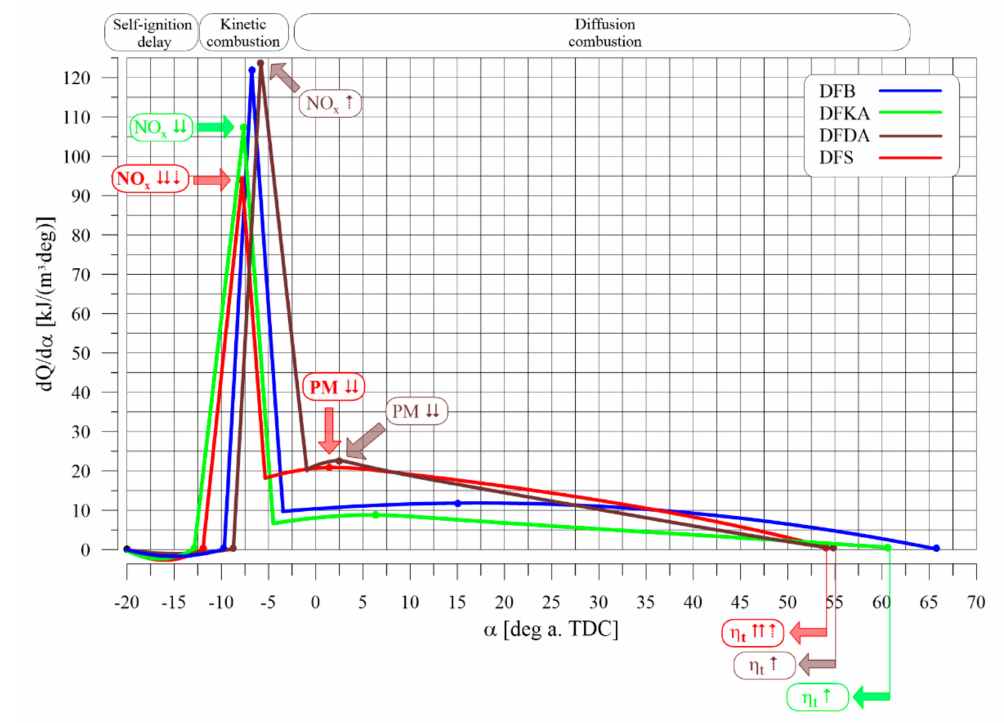
Figure 18. Heat release rate (dQ/d α ) in SB 3.1 engine cylinder for four tested fuels.